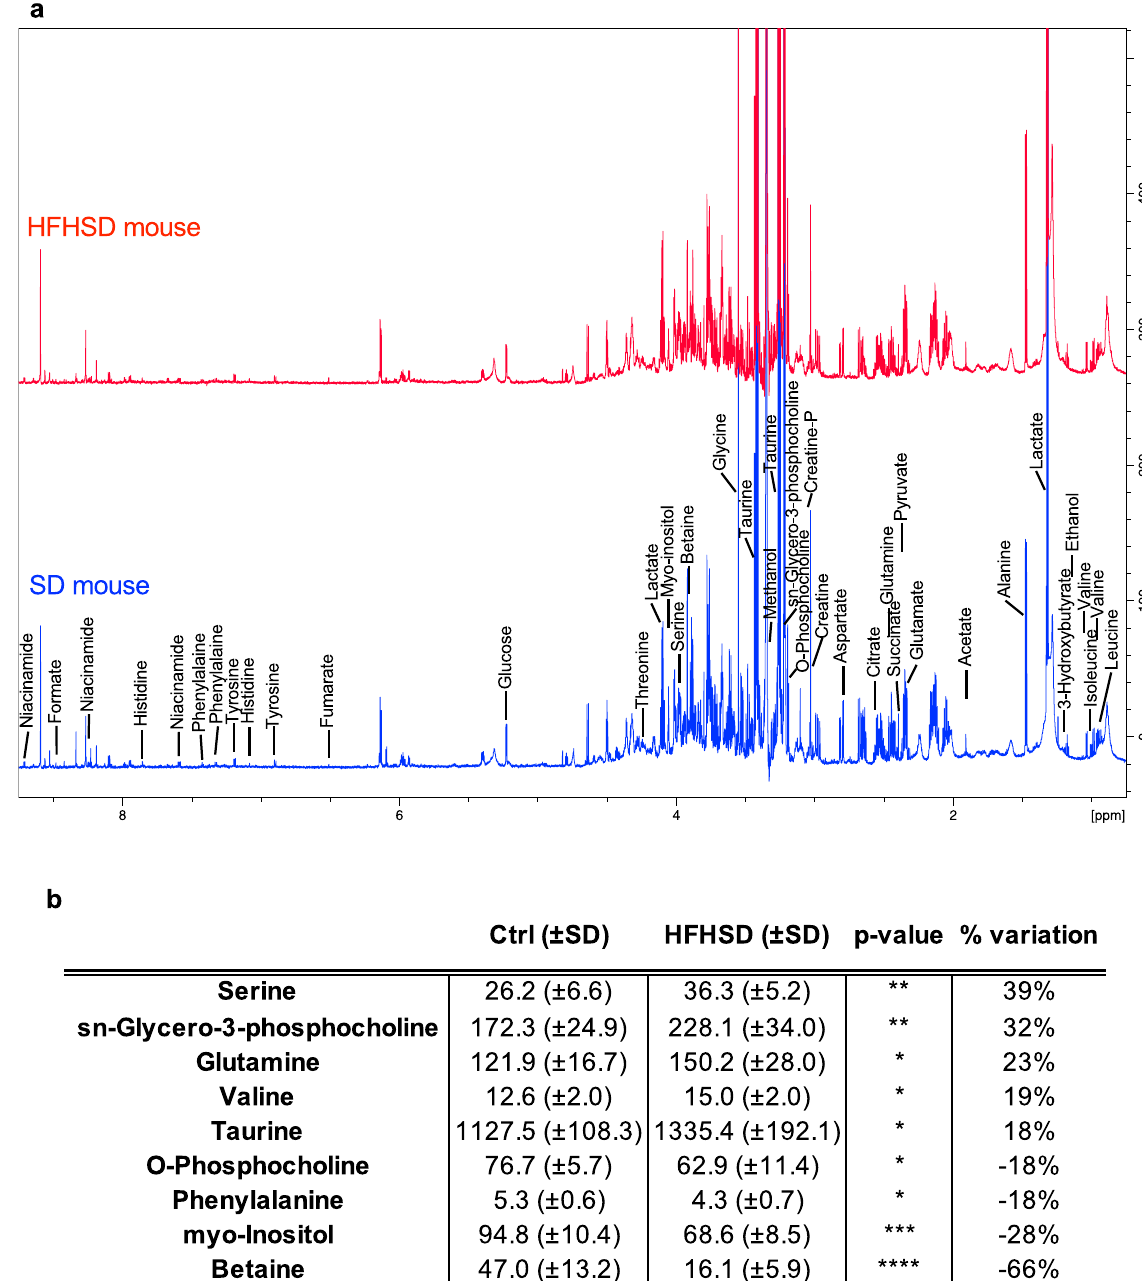
Figure 1. Metabolite modifications identified by NMR in the lung of HFHSD mice. ( a ) 1 H-NMR representative spectra from lung from SD (blue) and HFHSD (red) fed mice. ( b ) List of metabolites differentially found in the lung of HFHSD mice compared to SD mice. Results are expressed as mean ± standard deviation (SD) and are in nmol/100 mg of lung. Data are mean of n = 8 mice per group; Results of unpaired two-tailed t-test are indicated p < 0.05 (*), p < 0.01 (**), p < 0.001 (***) and p < 0.0001 (****). Percentages of variation between HFHSD and SD fed mice are indicated. All metabolites quantified including non-significant variation are reported in Table